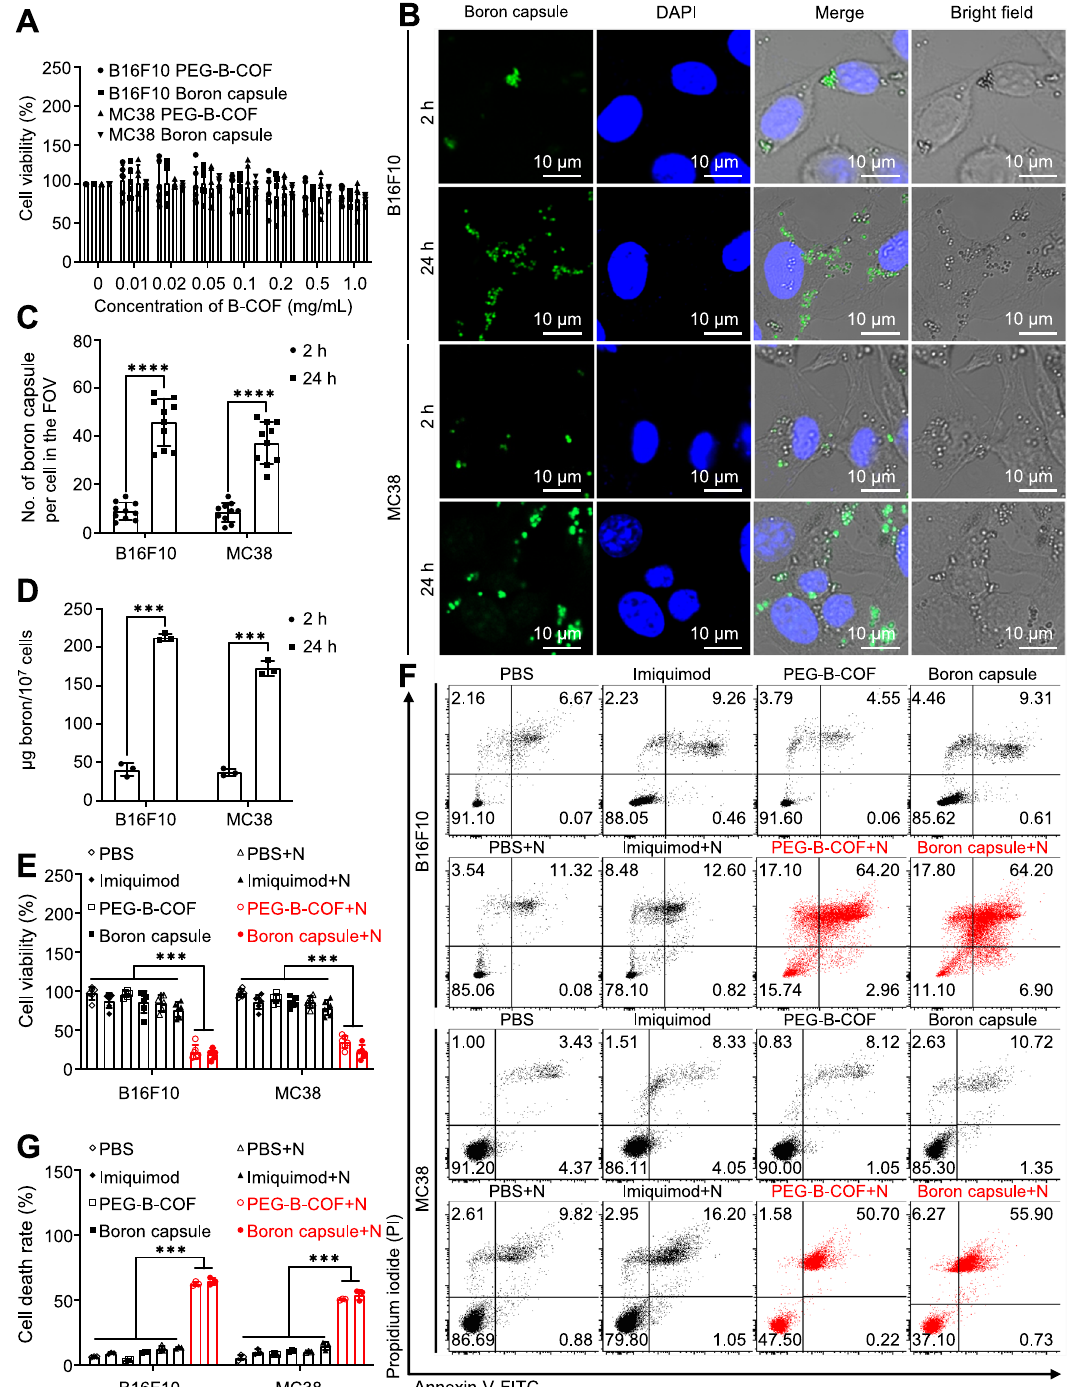
Fig. 3 | Cell uptake of boron capsule is notable and induces ef fi cient cell death after neutron irradiation. A Cell viability assays of boron capsule and PEG-B-COF in B16F10 and MC38 cancer cells ( n =6 independent experiments, P value < 0.0001), respectively. B Cell uptake of boron capsule is time-dependent. Repre- sentative confocal images of B16F10 and MC38 cells are shown after being treated byFITC fl uorophore-conjugatedboroncapsule(1mg/mL)for2hoursand24hours, respectively. Green fl uorescence clearly shows the cyto-distribution of boron capsules. C Number of boron capsule per cell in the giving fi eld of view (FOV) by confocal microscopy ( n =10 fi elds of view). D Boron contents in cancer cells ( n =3 indepe n dent experiments, P value <0.0001). E Ef fi cacy of BNCT on cell viability of